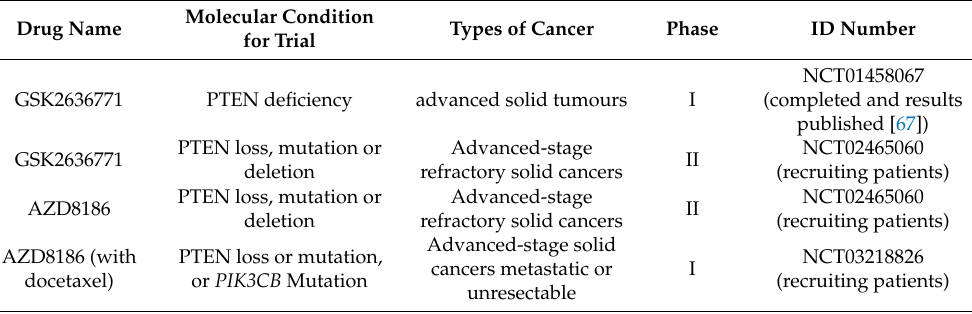
Table 2. Completed and planned clinical trials using p110 β